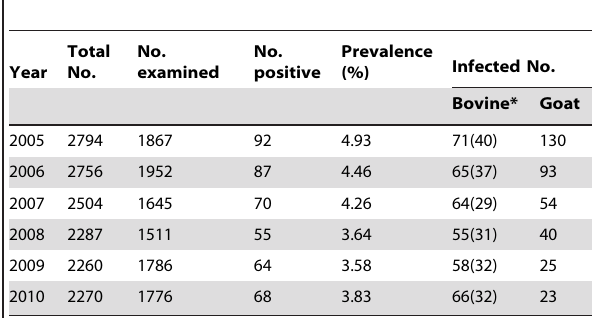
Table 1. Overall prevalence and the number of infected domesticated ruminants.